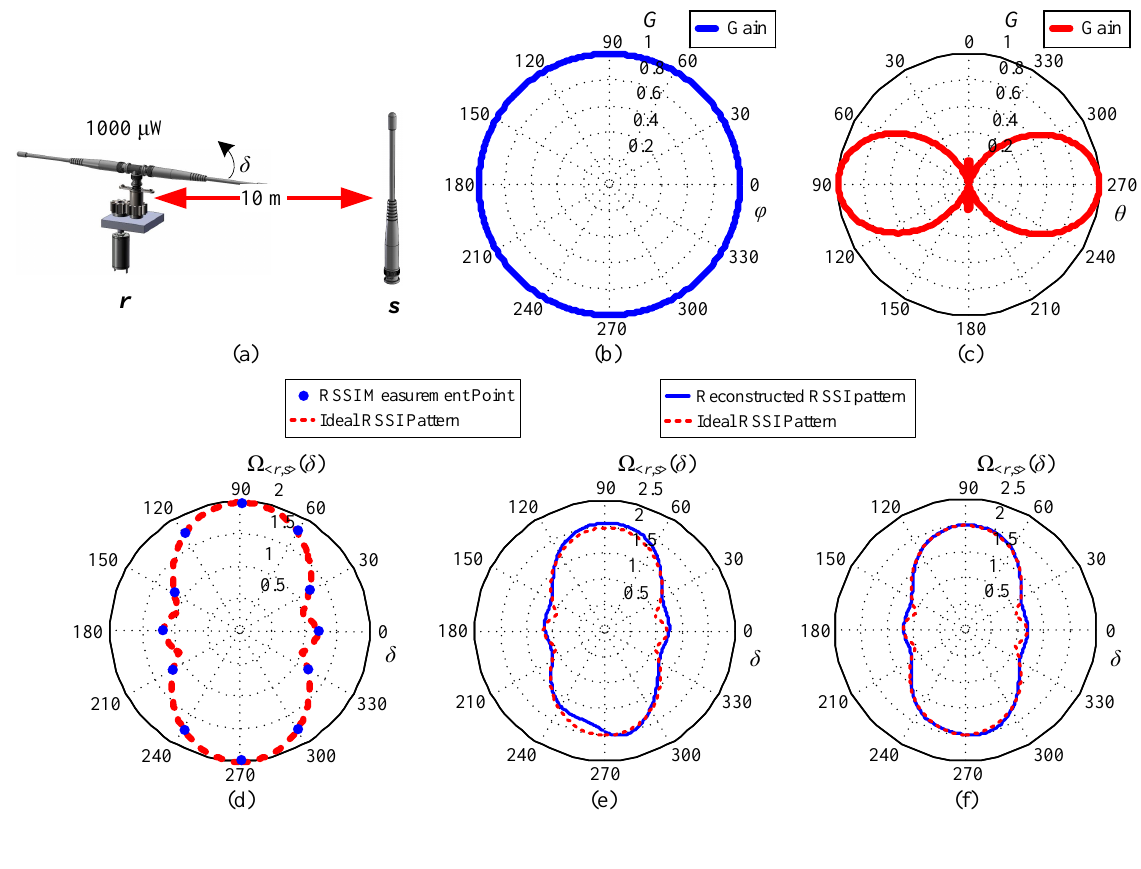
(c) The E-plane EM wave pattern of the omnidirectional antenna utilized in this study; (d) An ideal RSSI pattern and RSSI measurement points that are derived from Equation (2); (e) A reconstructed RSSI pattern after the antenna of the reference node completes the first cycle of rotation; (f) A stabilized RSSI pattern that is estimated by repeated RSSI